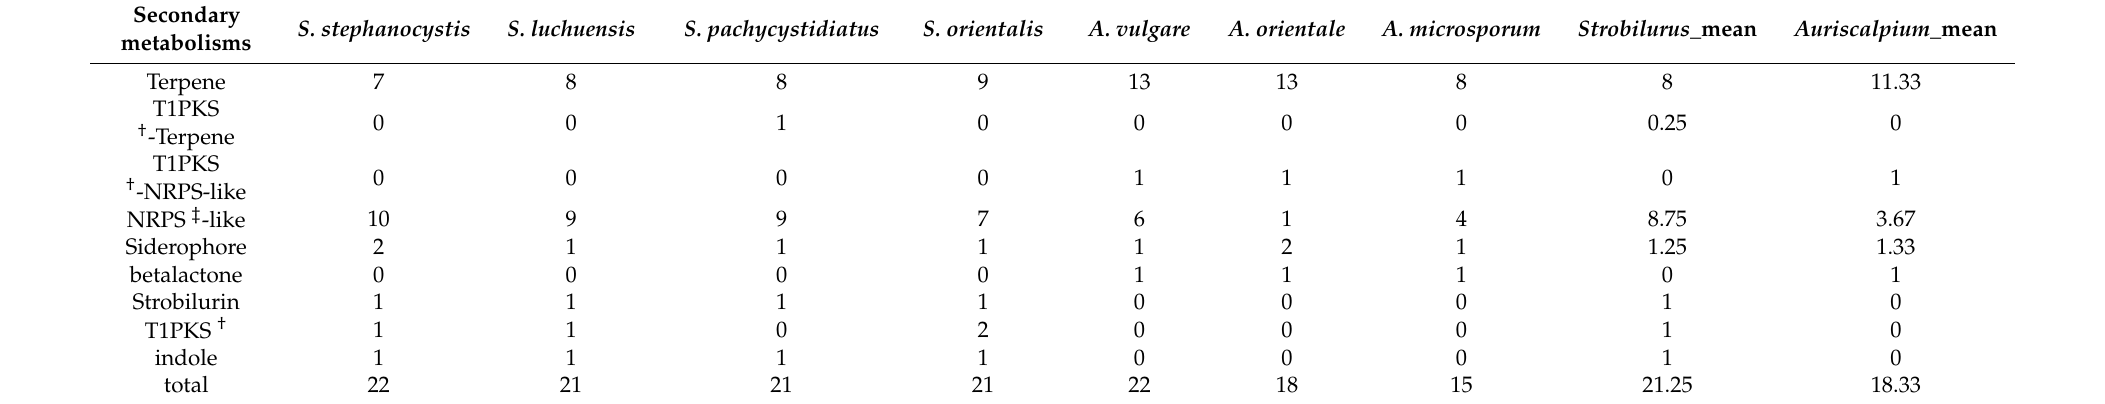
Table 3. Comparison of secondary metabolisms of fungi in Auriscalpium and Strobilurus